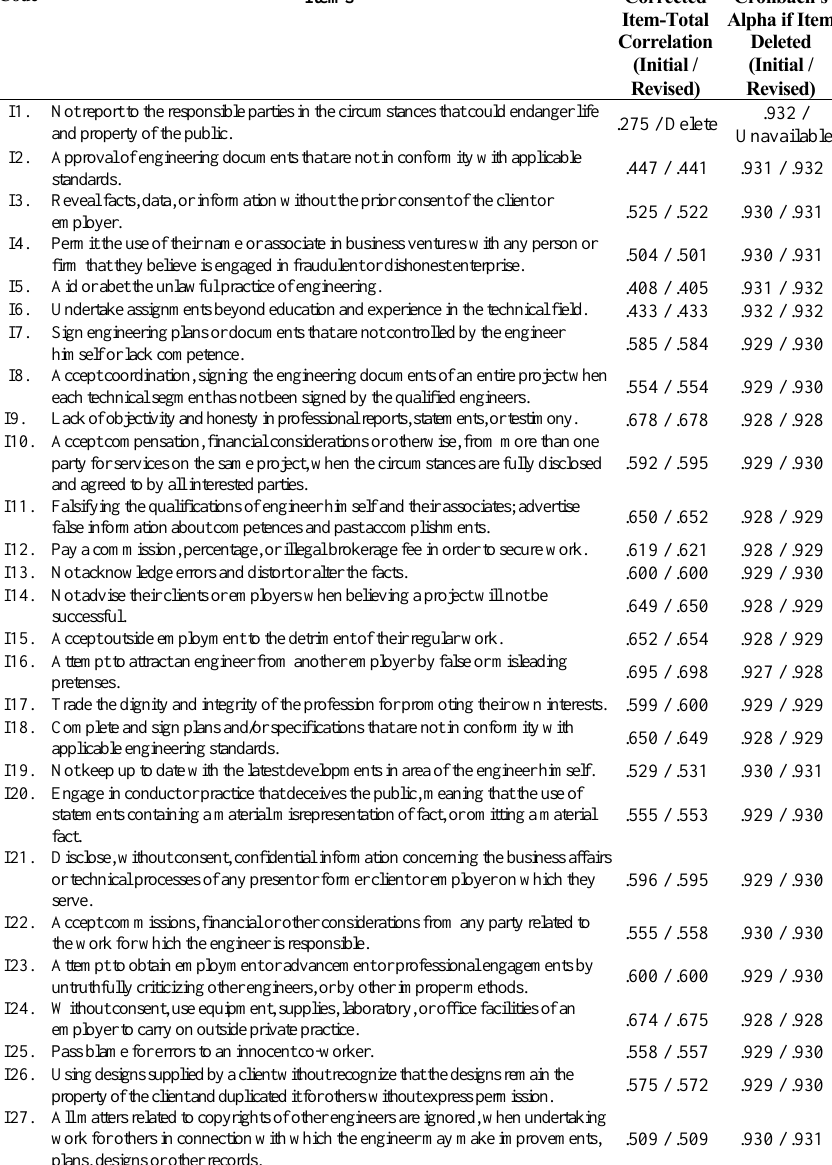
Table 1. Internal reliability